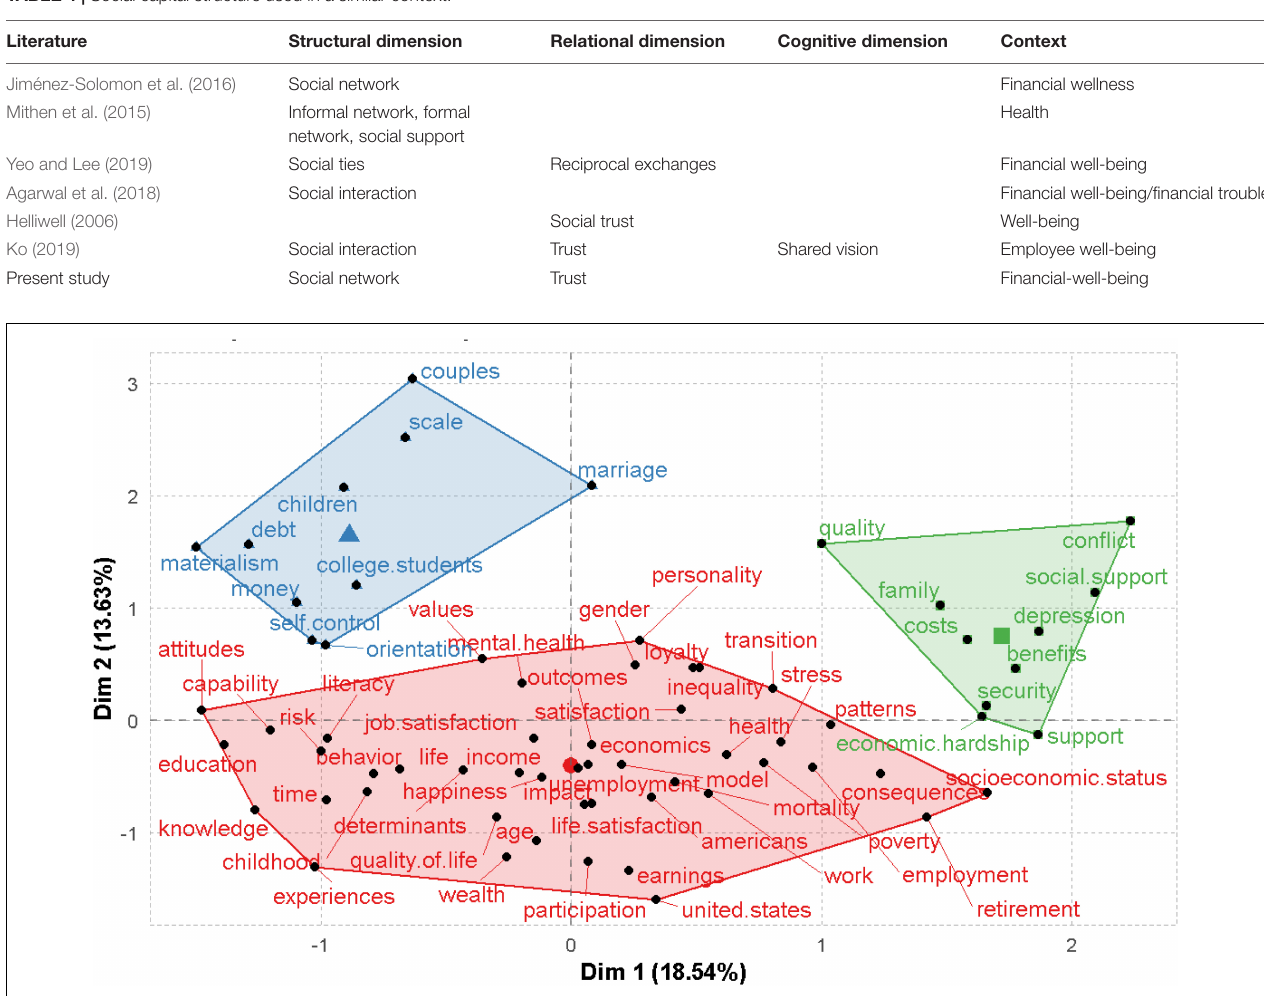
TABLE 4 | Social capital structure used in a similar context.